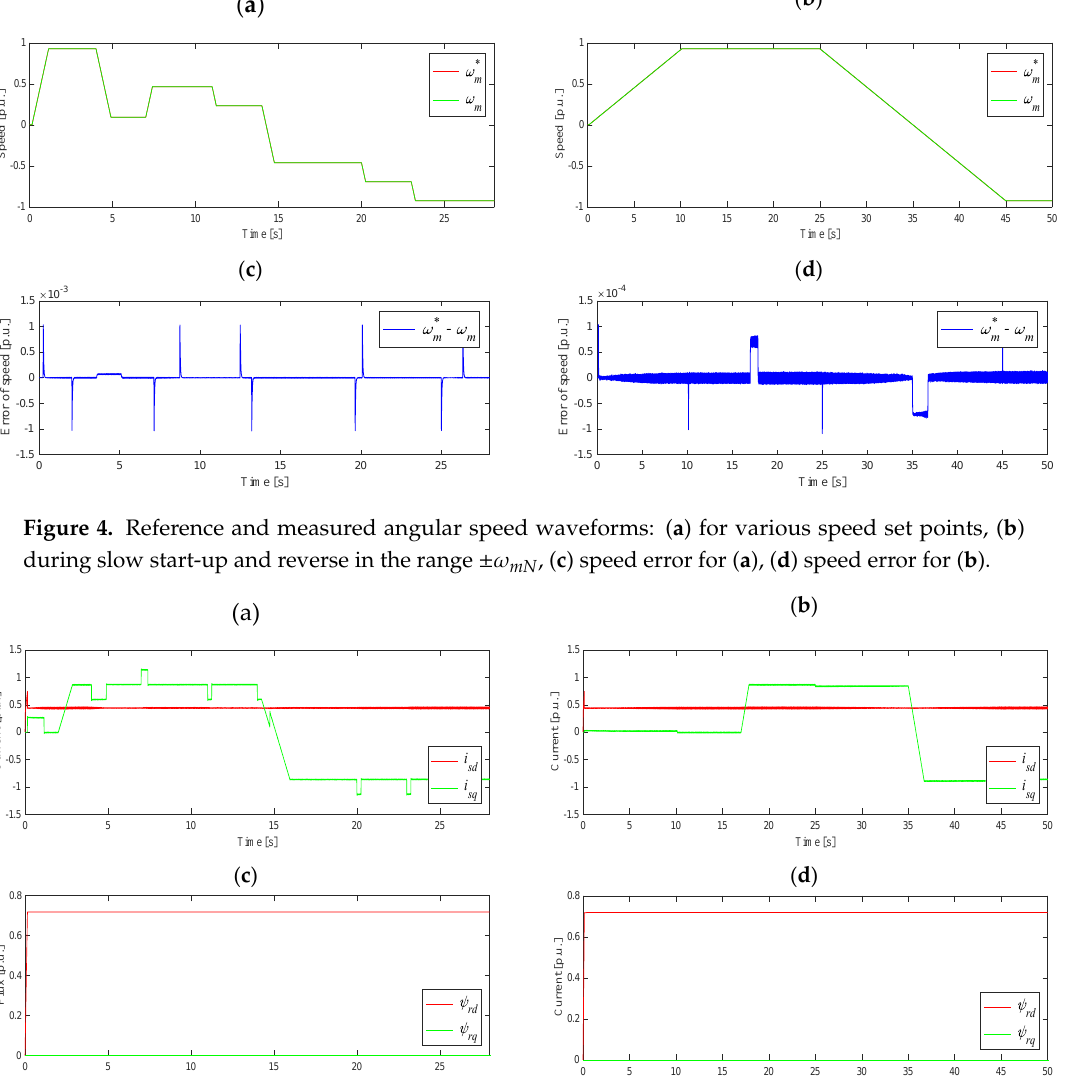
Figure 5. Waveforms of d – q components of the stator current and magnitude of the rotor flux vectors for different speed trajectories as in Figure 4a - ( a , c ), and in Figure 4b - ( b , d ).